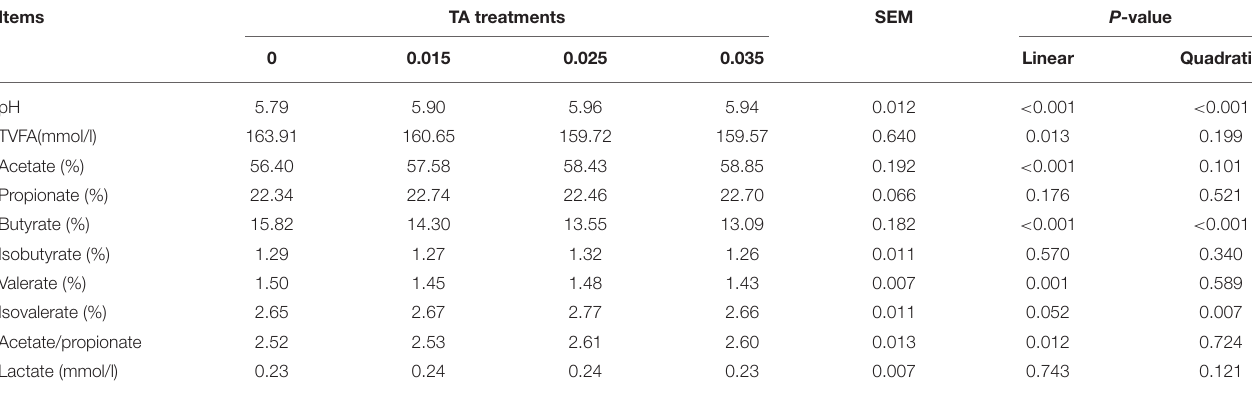
TABLE 2 | Effects of tannic acid concentration treatments of ground corn on in vitro fermentation characteristics and lactate concentration. Items TA